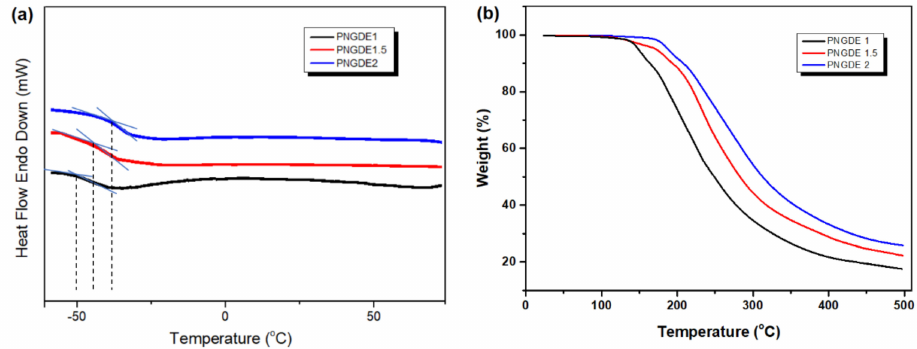
Figure 2. DSC curves ( a ) and TGA plots ( b ) of PNGDEs.